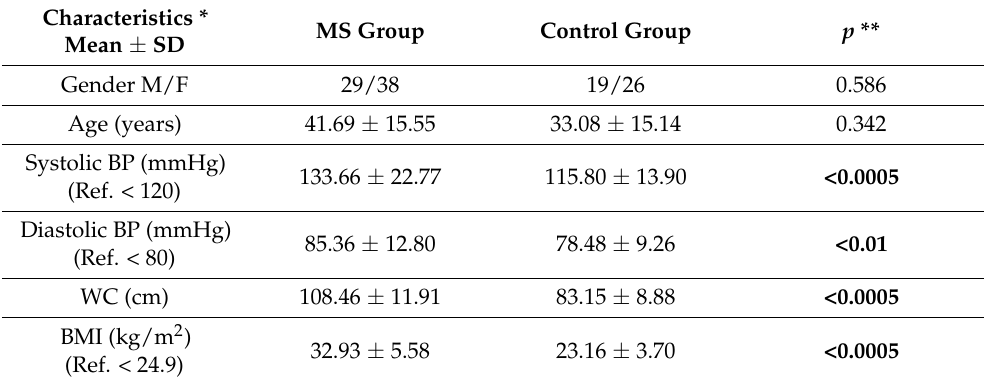
Table 1. Clinical characteristics of patients with MS (n = 67) and control group (n = 45).